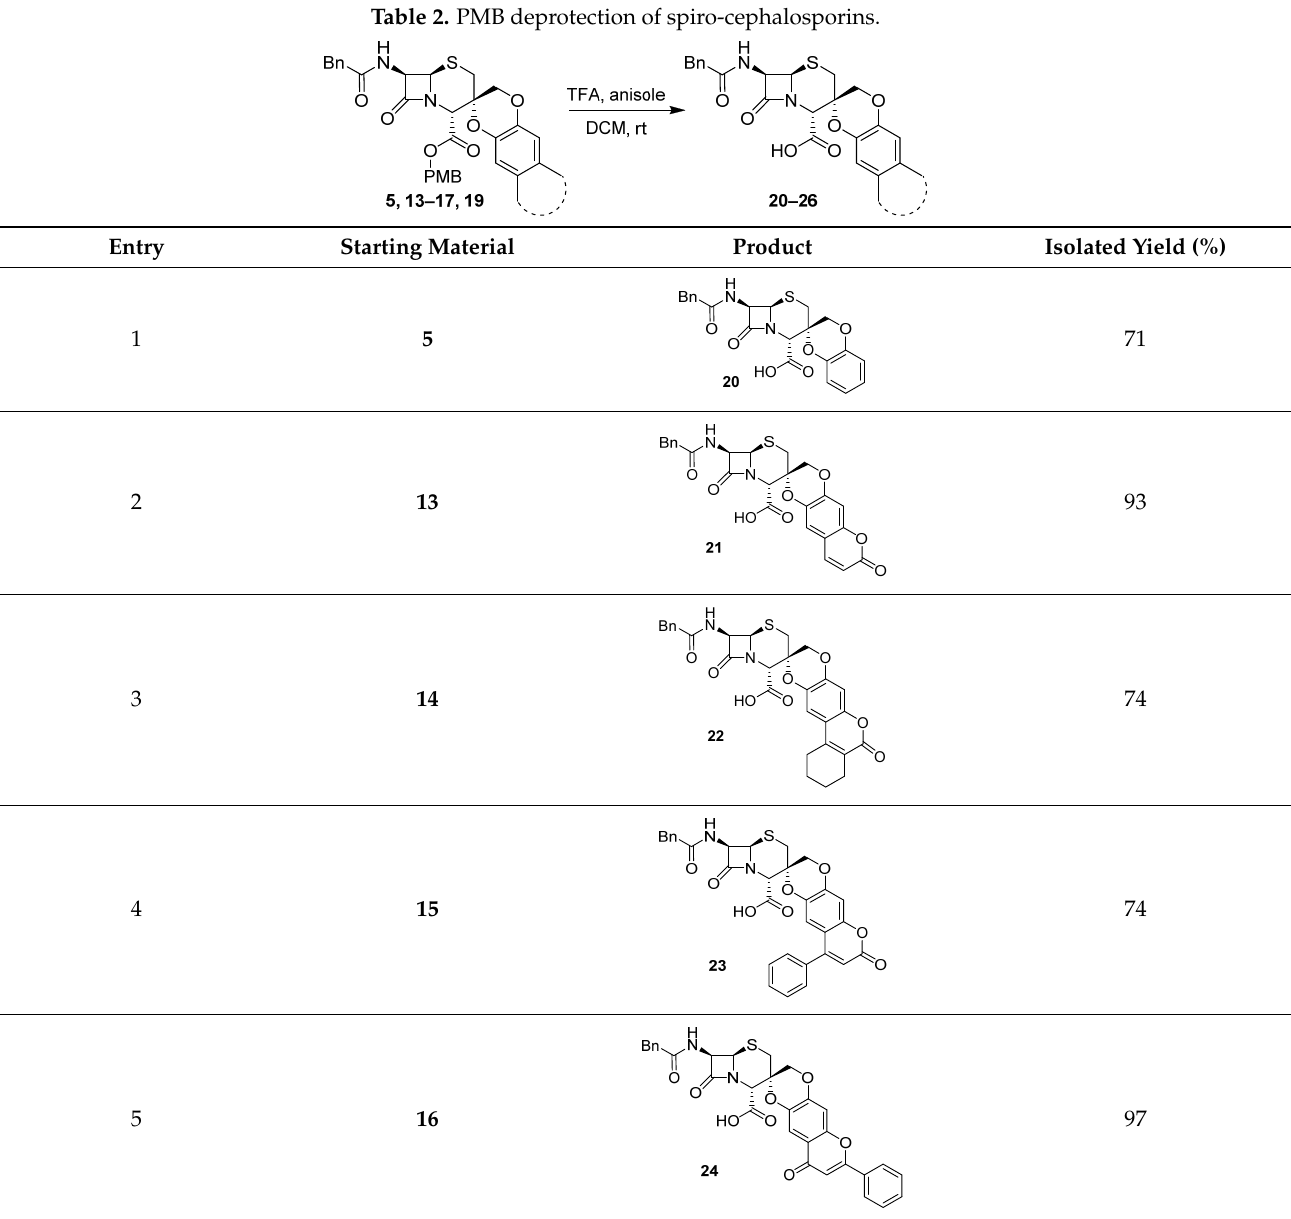
Table 2. PMB deprotection of spiro-cephalosporins.